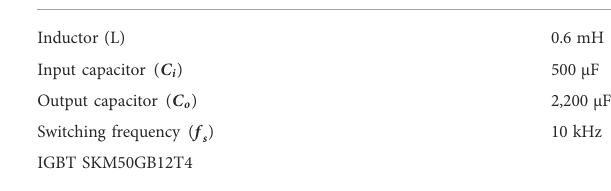
TABLE 2 Electrical speci fi cations of Boost converter. Electrical speci fi